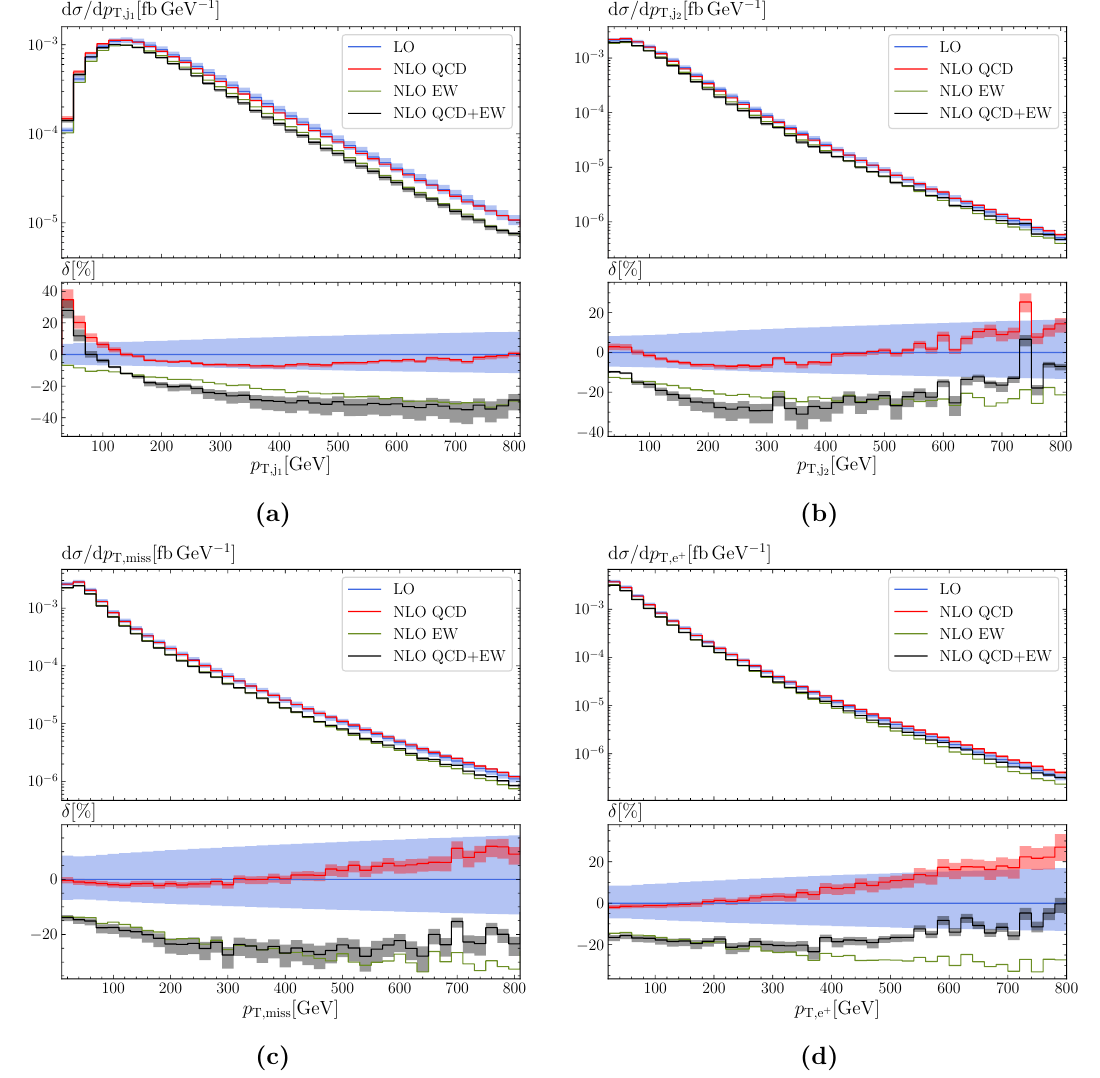
Figure 6. Di(cid:11)erential distributions for pp (a) transverse momentum of the hardest jet (top left), (b) transverse momentum of the second hardest jet (top right), (c) missing transverse energy (bottom left), and (d) transverse momentum of the positron (bottom right). The upper panel shows the LO contributions of order